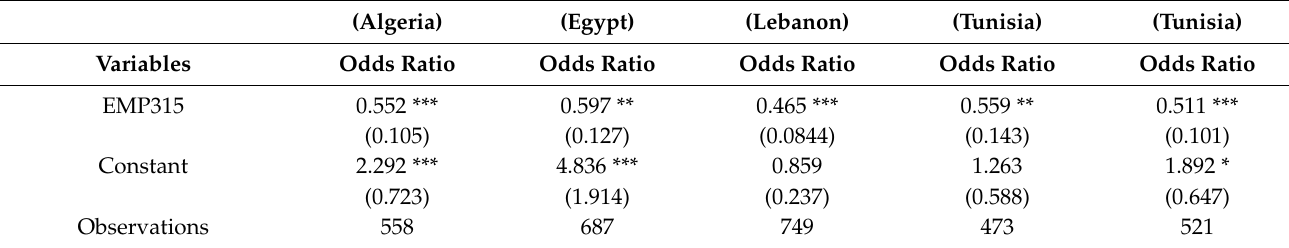
Table A10. Logistic regression on the “vote” index by